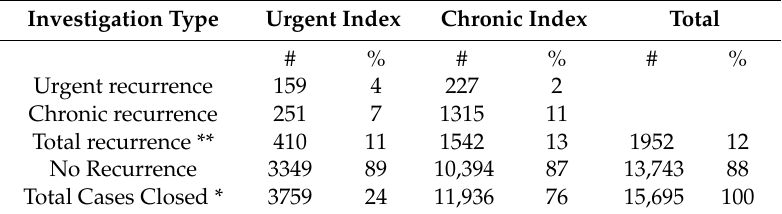
Table 1. 12-Month service recurrence of child protection concerns after a closed investigation (SPI-4) by urgent or chronic classification for 2013/14 (6 agencies) (As reported by Fallon and colleagues [61]).